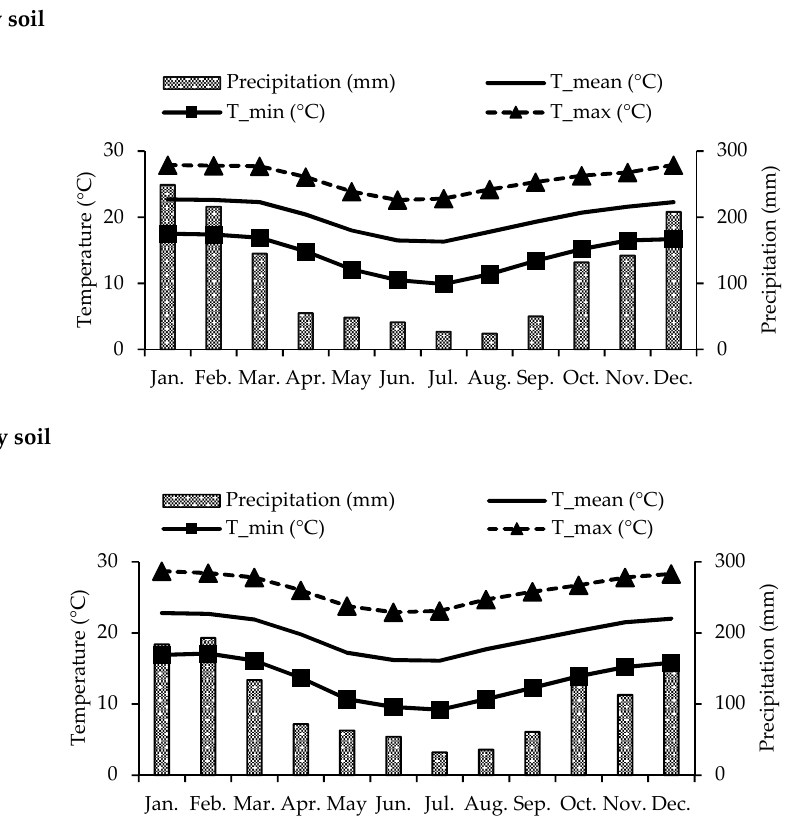
Figure 1. Mean monthly temperature (maximum, mean, and minimum) (°C) and mean annual precipitation (mm) for Sandy soil (near the city of Brotas-SP) and Clayey soil (near the city of Manduri-SP). Source: climate-date.org (https://pt.climate-data.org/). Table 2. History of land use and description of management practices conducted in each study area. Site Use * Description